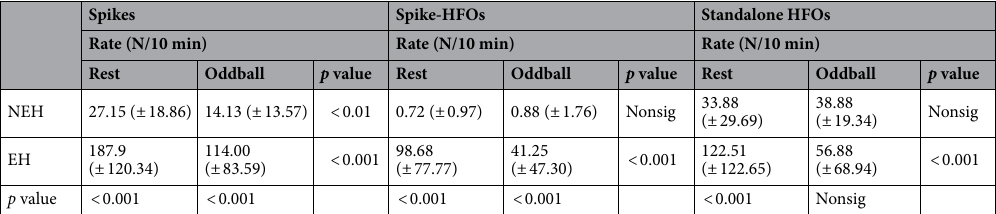
Table 4. Spikes, spike-HFOs and standalone HFOs rates per contact during rest and the oddball